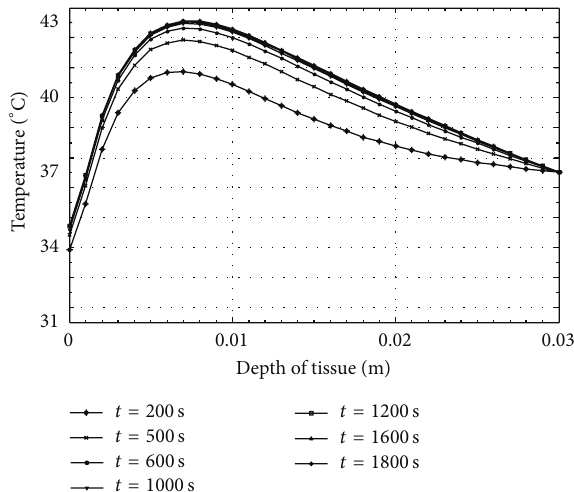
Figure 6: Transient spatial temperature distribution inside the